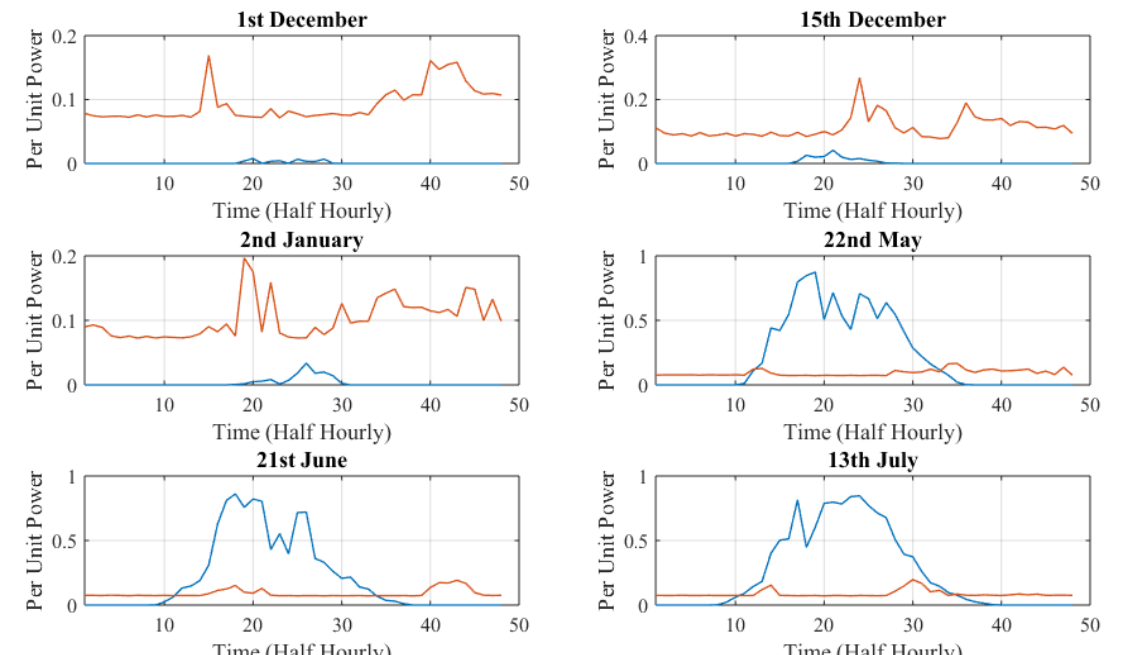
Figure 1. Per unit power profile of solar photovoltaics (PV) generation and the load of different days in a year.